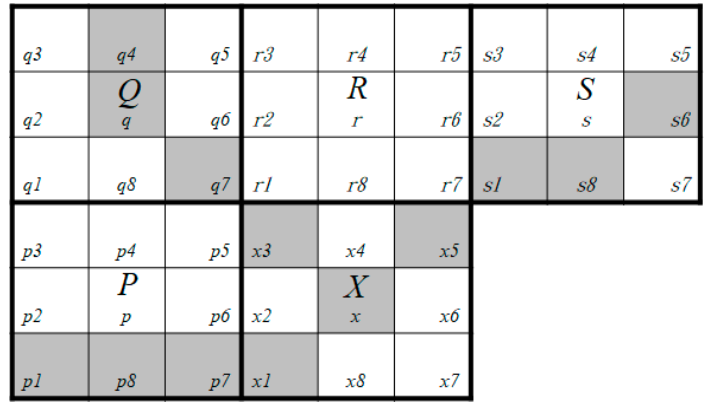
Figure 10. Schematic of texture extension of adjacent blocks.